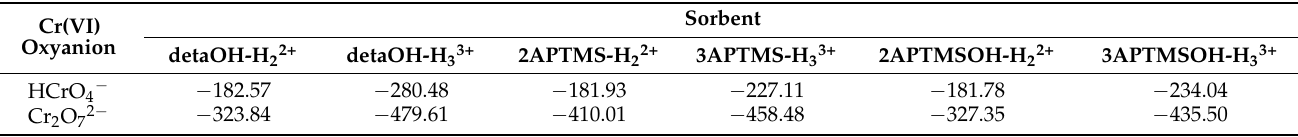
Table 6. The calculated energies of interactions (in kcal/mol) between chromium oxyanion and cationic sorption